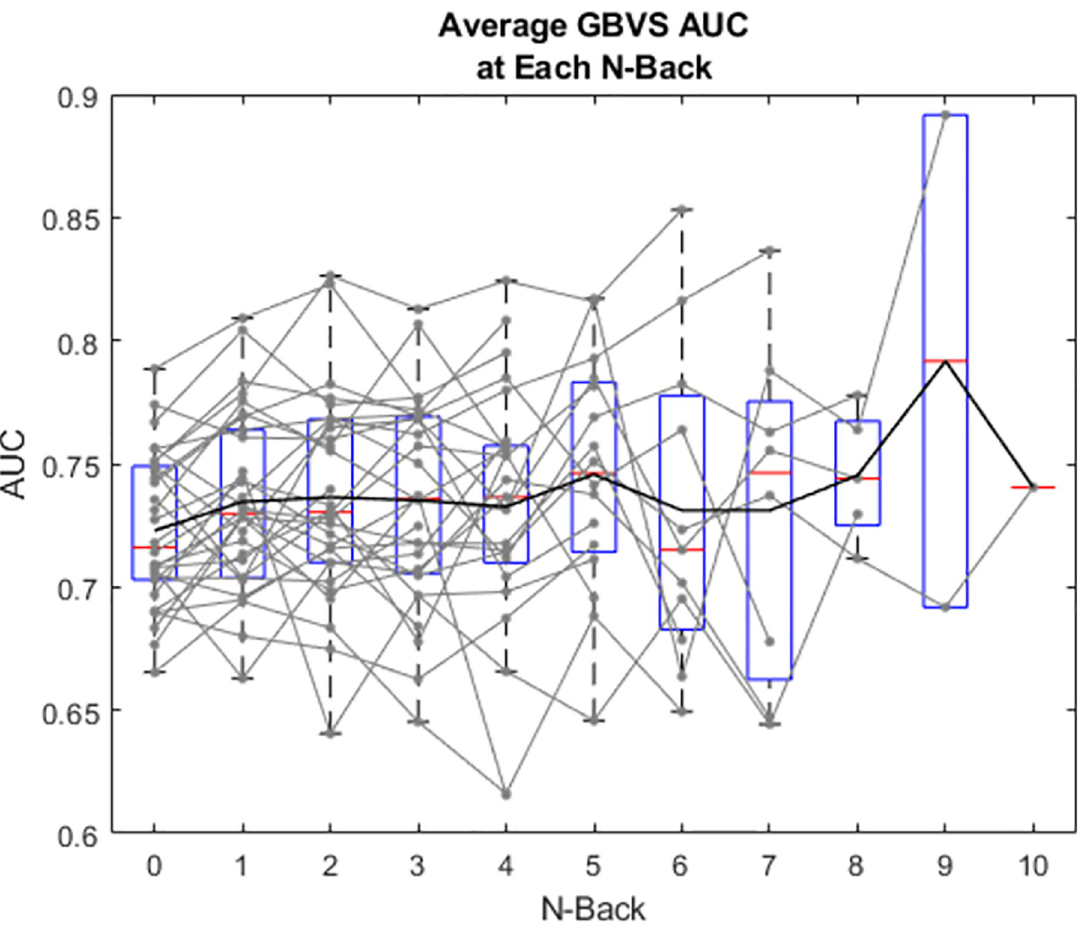
Fig 5. Area under the ROC curve for GBVS prediction of gaze at each N-back. Grey lines represent individual subjects. Black line represents mean values, red lines show median, boxes show interquartile range and whiskers show 95% confidence intervals.